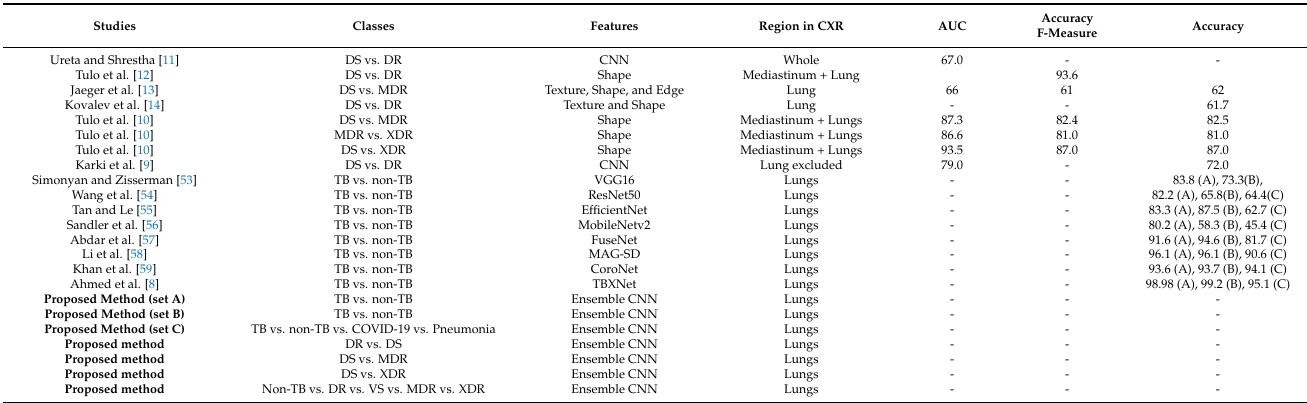
Table 12. Details of the compared method in existing research (cid:5)